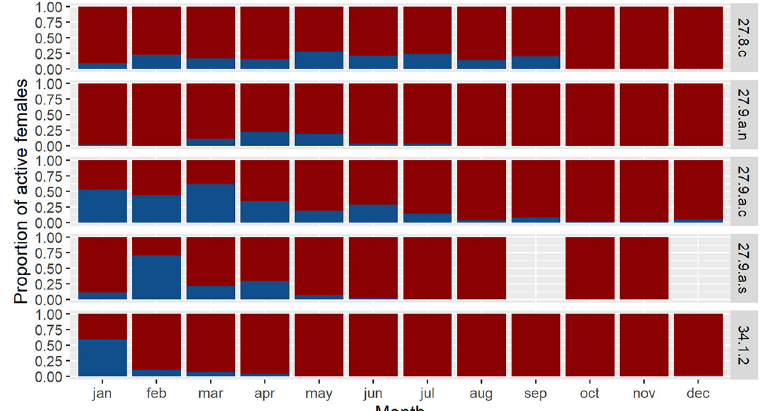
Fig. 4. – Monthly proportion of sexually active (blue) and inactive (red) females in each study area. Geographical study areas from south to north are 34.1.2, Canary Islands; 27.9.a.s, Gulf of Cadiz; 27.9.a.c, W Portuguese coast; 27.9.a.n, NW Spanish coast; 27.8.c., Cantabrian